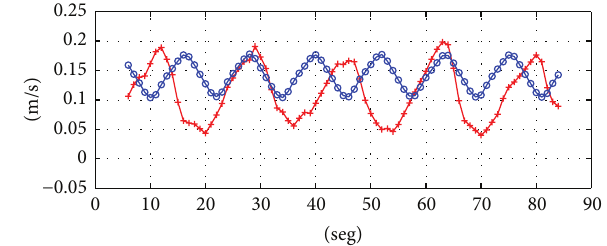
Figure 11: Comparing measurement data (+) and simulated data ( ∘ ) of the velocity component 𝑈 on the viewer 𝑉 1 obtained using the ml-05 model.